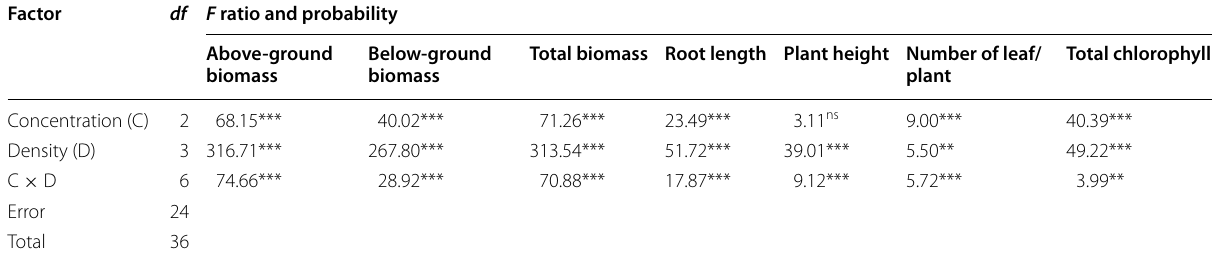
Table 2 Results of two-way ANOVA ( F -ratios) showing the effects of Phragmites australis litter leachate (C) on seedling densities (D) of Rumex conglomeratus